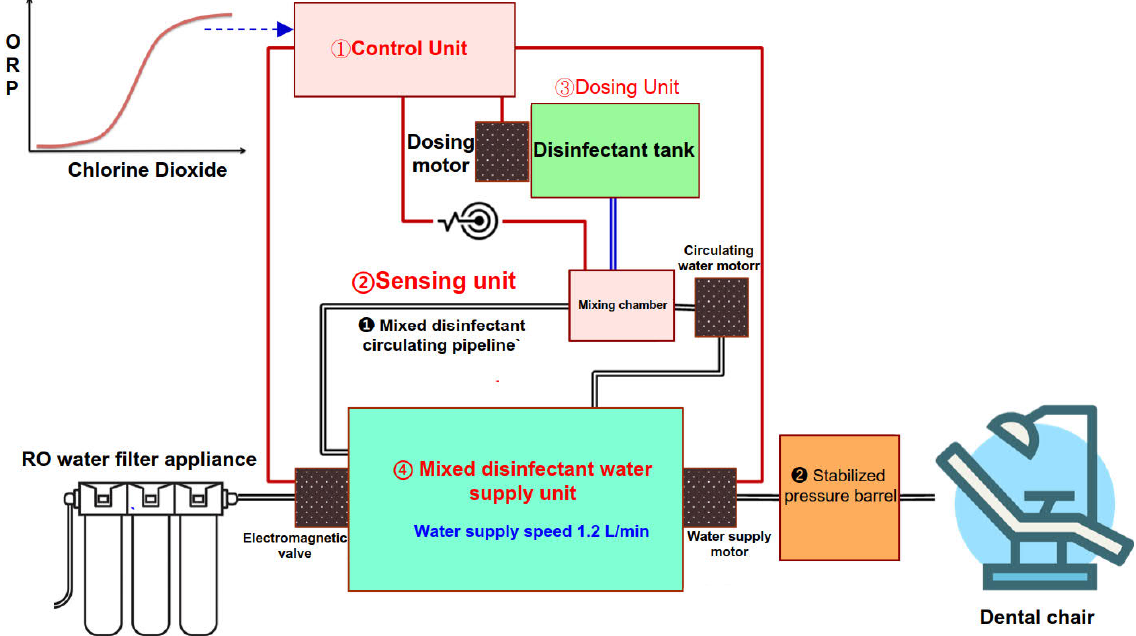
Figure 1. ACD dental chair including control unit, ORP sensing unit, disinfectant dosing unit, and mixed disinfectant water supply unit.